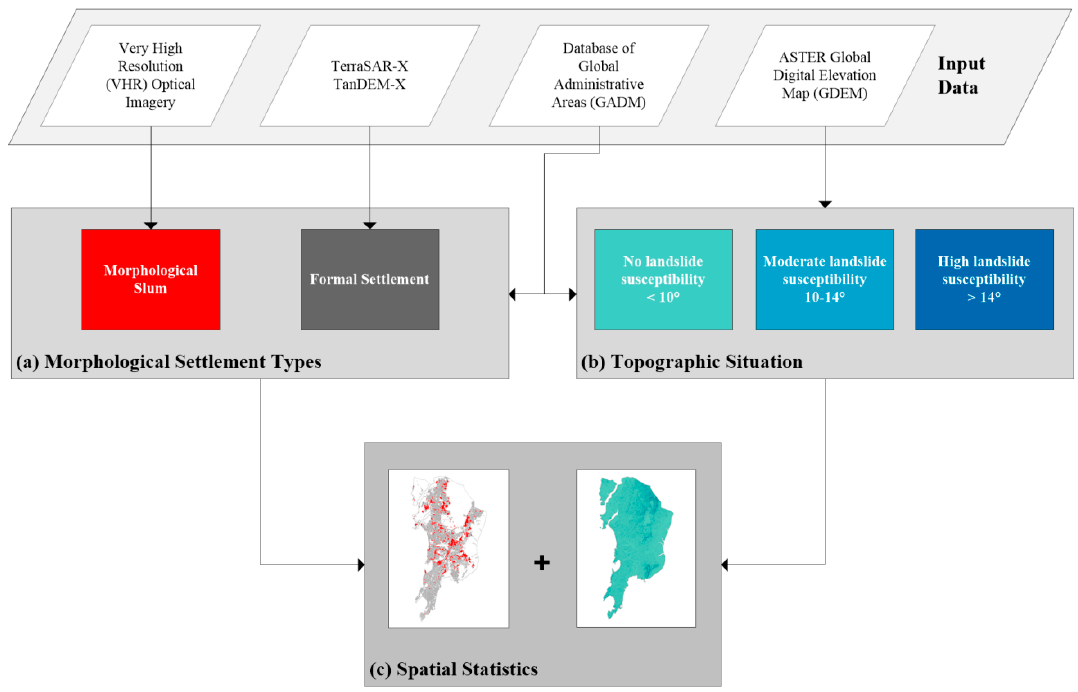
Figure 1. General workflow and data sources for the classification of morphological settlement types ( a ), the evaluation of the topographic situation ( b ) and the derived spatial statistics ( c ).